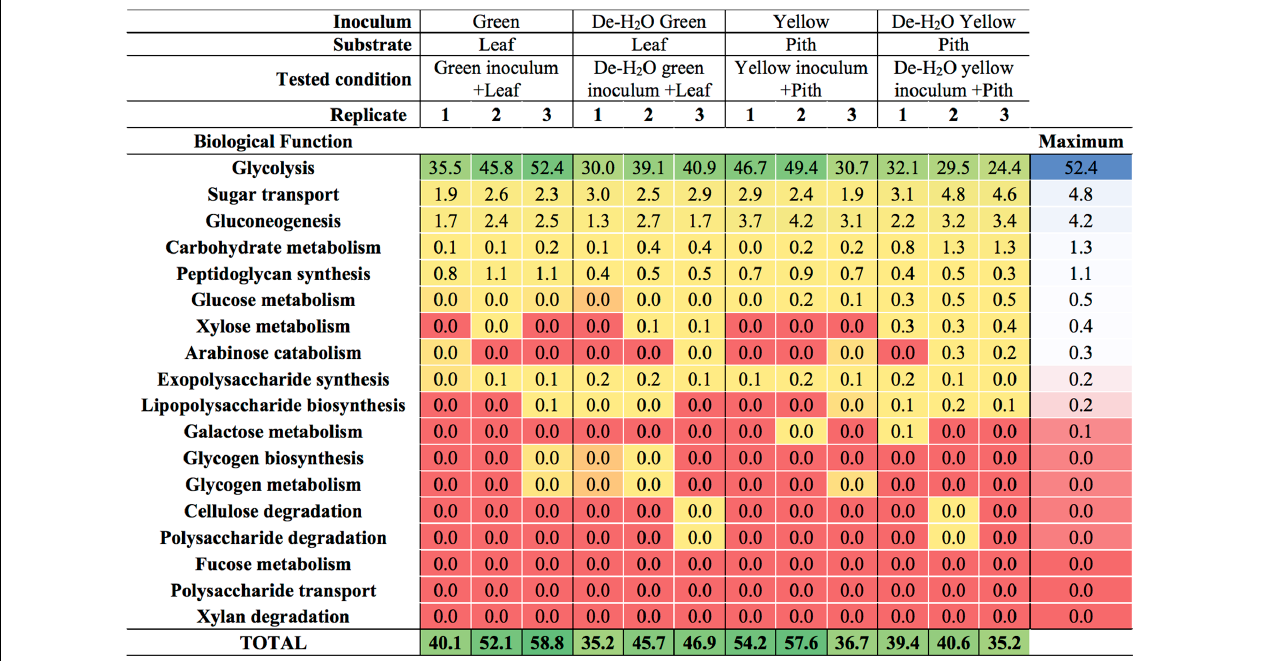
simulation of giant panda’s selectiveness for different bamboo portions. This was attained through either uniquely ‘green’ or ‘yellow’ lab-scale fermentations, where both bamboo portions (either leaf or pith, respectively) and their correspondent gut microbiomes were used ( Figure 2